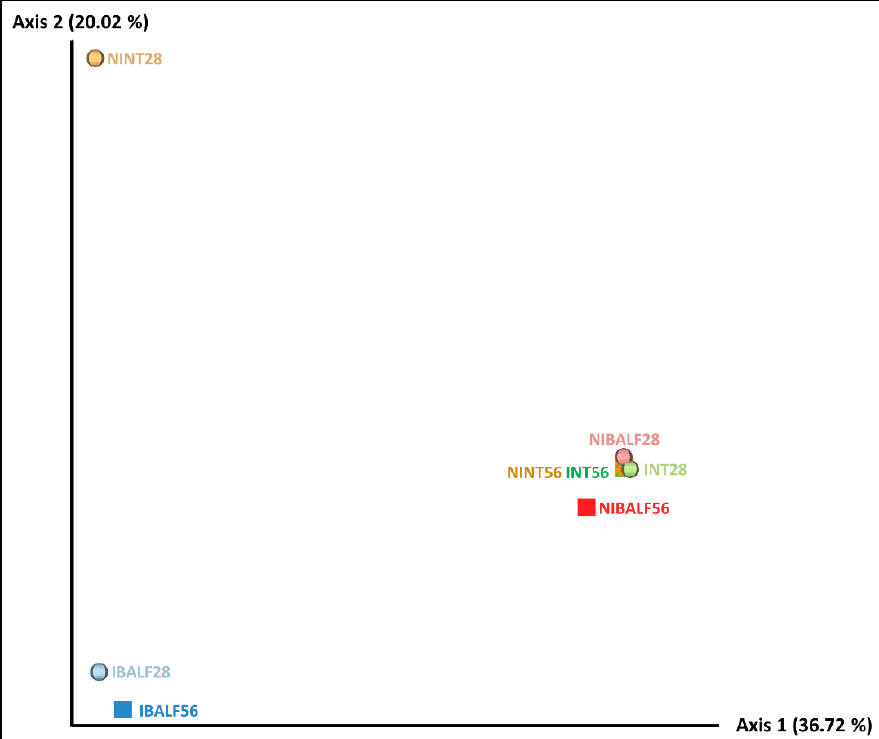
Figure 1. Unweighted unifrac distance PCoA diagrams with pooled nasal turbinate (NT) and bronchus-alveolar lavage fluid (BALF) samples of infected and non-infected animals at 28 and 56 days post-inoculation (dpi). NINT28 = non-infected NT 28 dpi; NINT56 = non-infected NT 56 dpi; NIBALF28 = non-infected BALF 28 dpi; NIBALF56 = non-infected BALF 56 dpi; INT28 = infected NT 28 dpi; INT56 = infected NT 56 dpi; IBALF28 = infected BALF 28 dpi; IBALF56 = infected BALF 56 dpi .